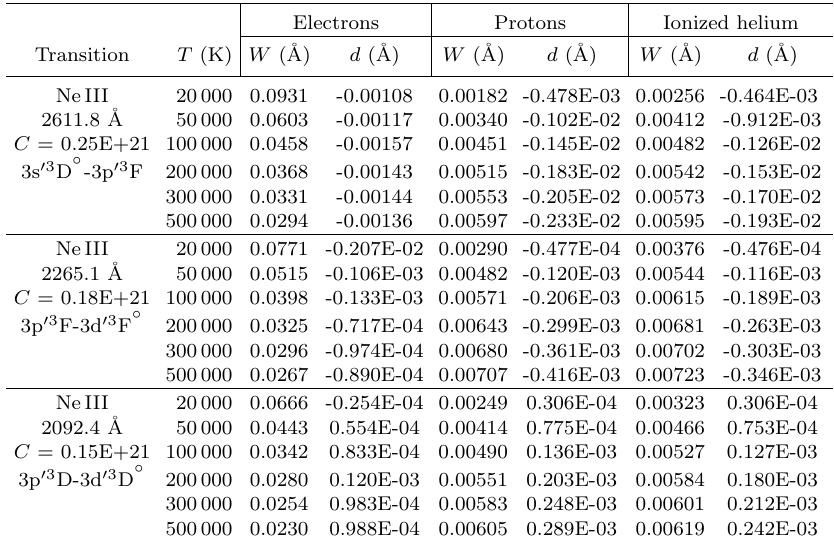
Table 3. Stark broadening parameters for Ne III multiplets for a perturber density of 10 17 cm − 3 . Designations are the same as in Table 1. Electrons Protons Ionized